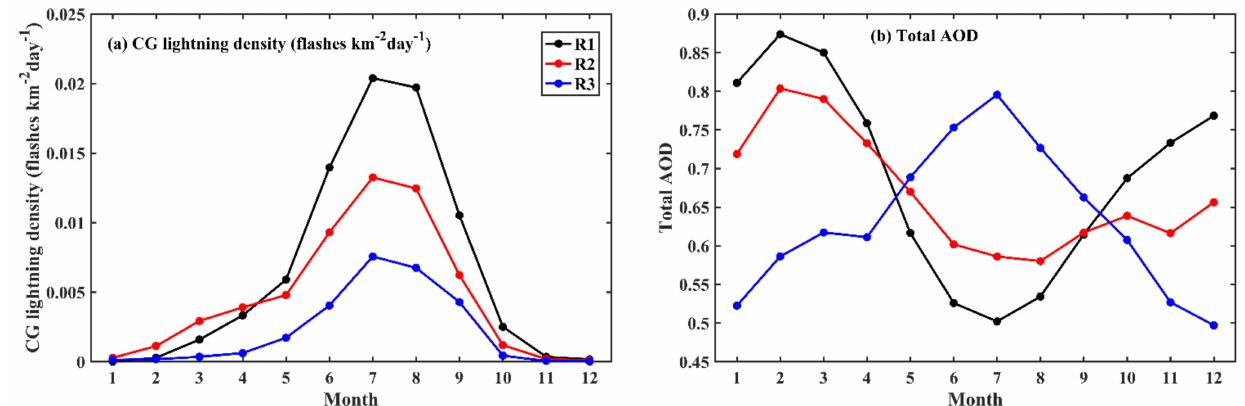
Figure 3. Monthly variations in mean ( a ) CG lightning density (unit: flashes km − 2 day − 1 ) and ( b ) total AOD during 2010–2018 over three study regions R1, R2, and R3). All AOD data are derived from